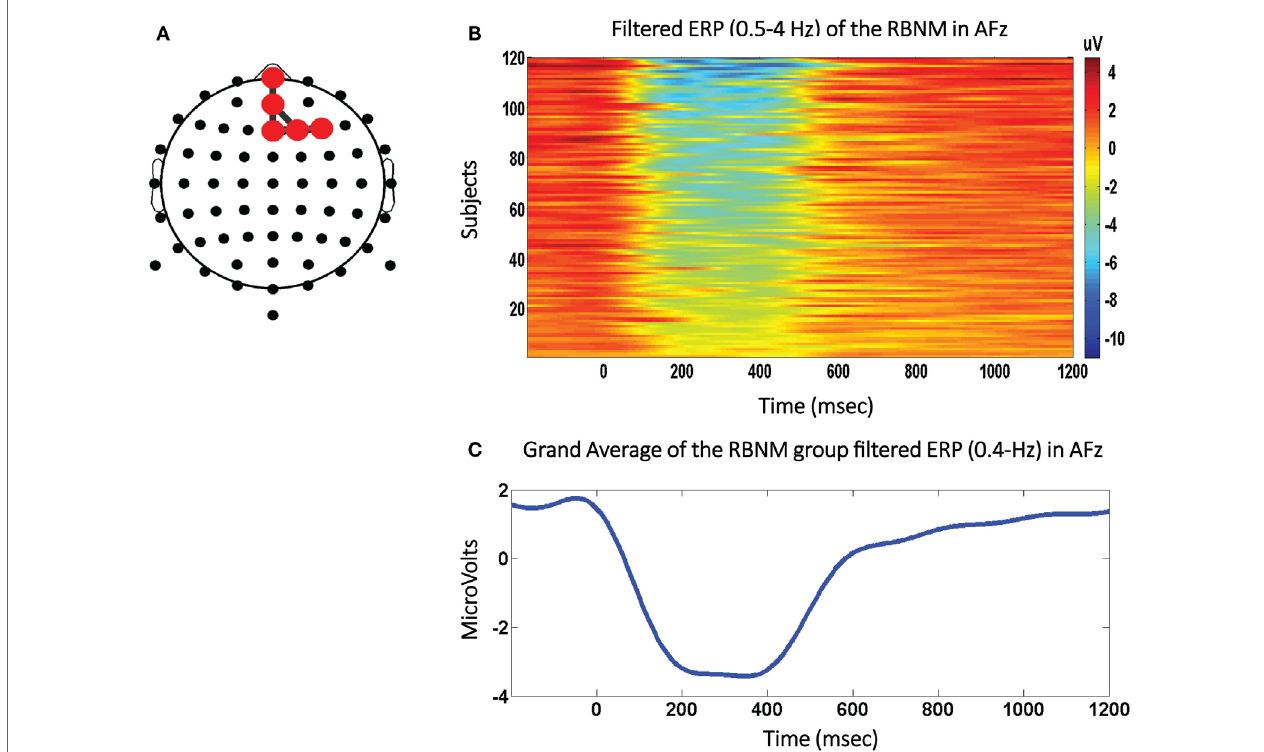
FIGURe 1 | the negative shift biomarker . (a) The Reference Brain Network Model (RBNM) is displayed on the right side. The red dots represent delta band activations recorded from fronto-midline electrodes (FPz, AFz, and Fz) and from electrodes on the right side (F2 and F4). (B) The colored panel depicts individual peak activations recorded from each of 120 subjects included in the RBNM. (C) The delta band-passed grand average (120 subjects). The negative peak was most prominent during the ~200–400-ms interval observed at the electrodes included in the RBNM (a)